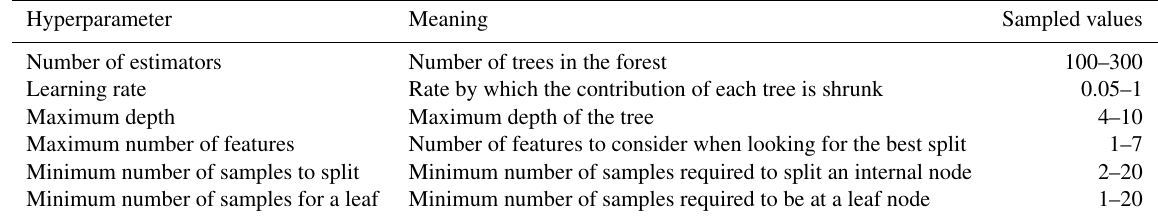
Figure 2. Qualitative illustration of the concept used to temporally extrapolate the 100m modeled wind speed boundary condition and parametric uncertainty through the proposed machine-learning and analog ensemble approaches. Wind speed uncertainty is directly quantified as its WRF across-ensemble normalized standard deviation (Eq. 1) for the single year in which ensembles were run and then extrapolated to the remaining 19 years, which were run with only a single WRF setup using the proposed GBM and AnEn approaches. Table 2. Hyperparameters considered for the gradient-boosting model.